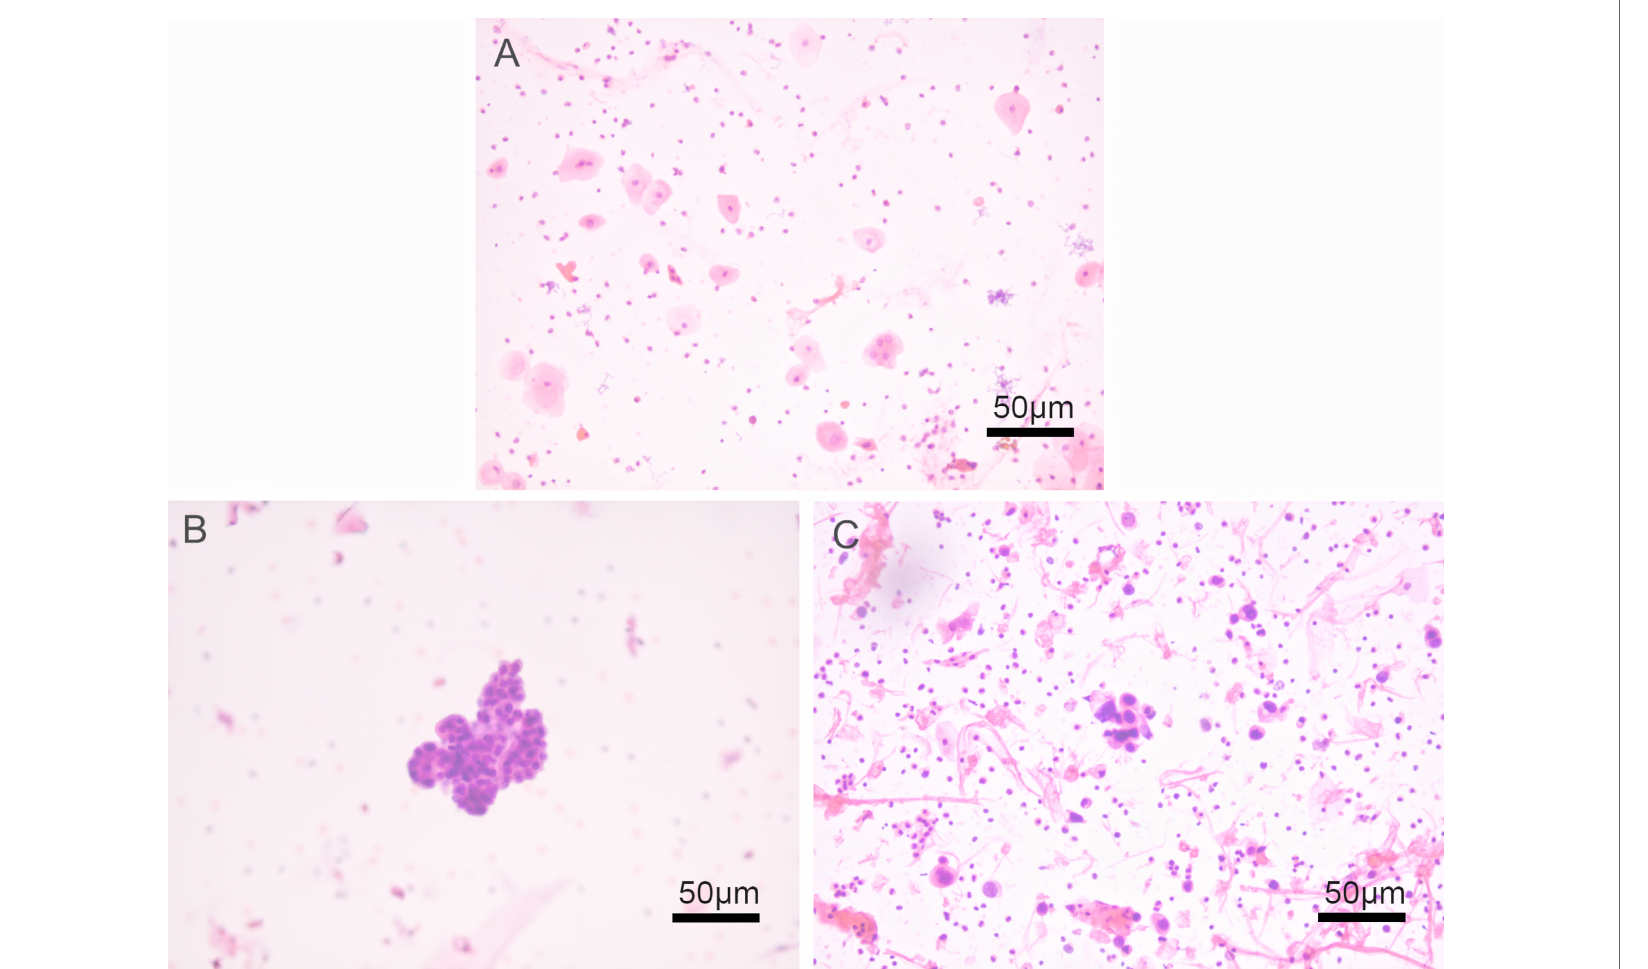
FIGURE 1 | Histological patterns of preoperative urine cytology by HE staining in upper urinary tract urothelial carcinoma (UUT-UC) patients. (A) Negative urine cytology at a magni fi cation of ×200; (B) suspicious urine cytology at a magni fi cation of ×200; and (C) positive urine cytology at a magni fi cation of